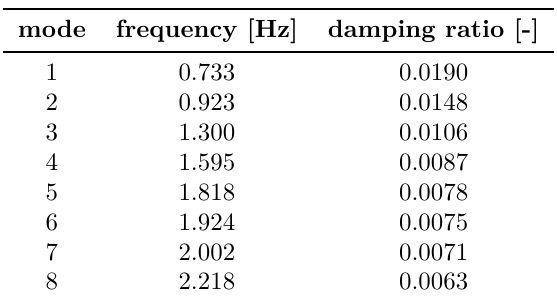
Table 1. Natural frequencies and damping